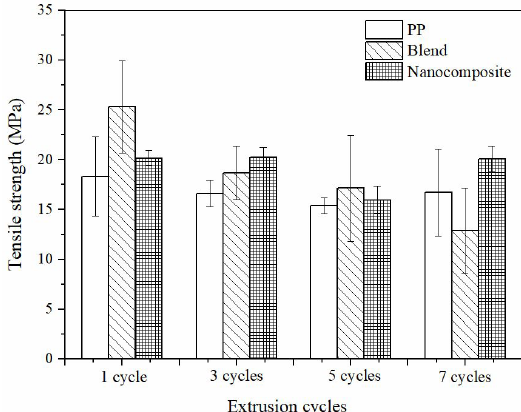
Figure 6. Tensile strength at break.